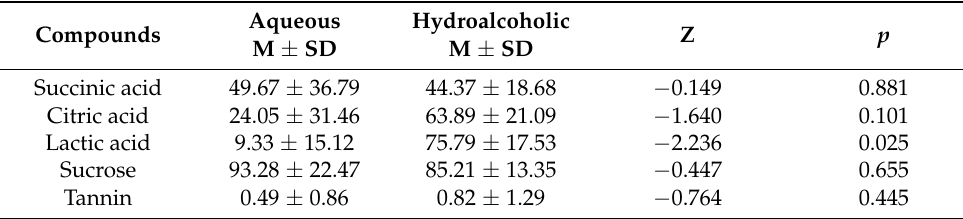
Table 4. Comparison of compounds in aqueous and hydroalcoholic solutions and results of